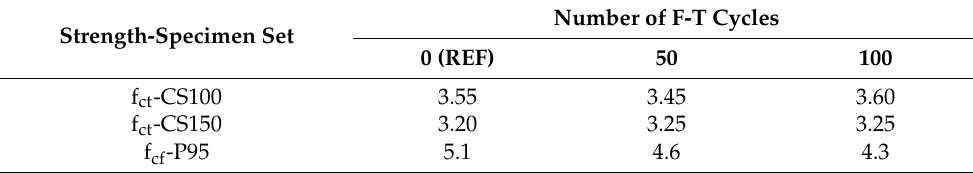
Table 2. Average tensile splitting f ct and flexural f cf strengths of the test specimens after 0, 50 and 100 F-T cycles.